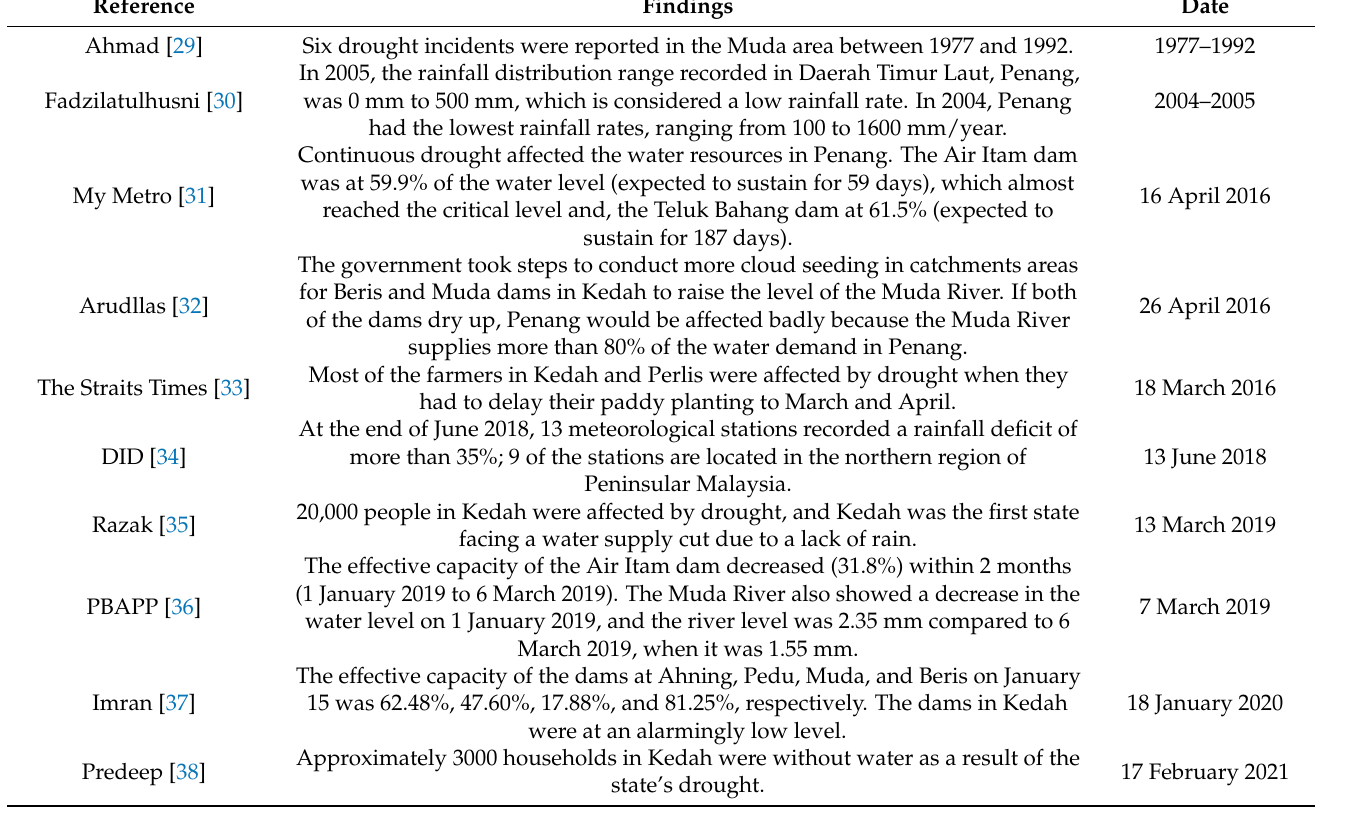
Table 1. Reported drought events within and surrounding the Muda River basin (MRB).